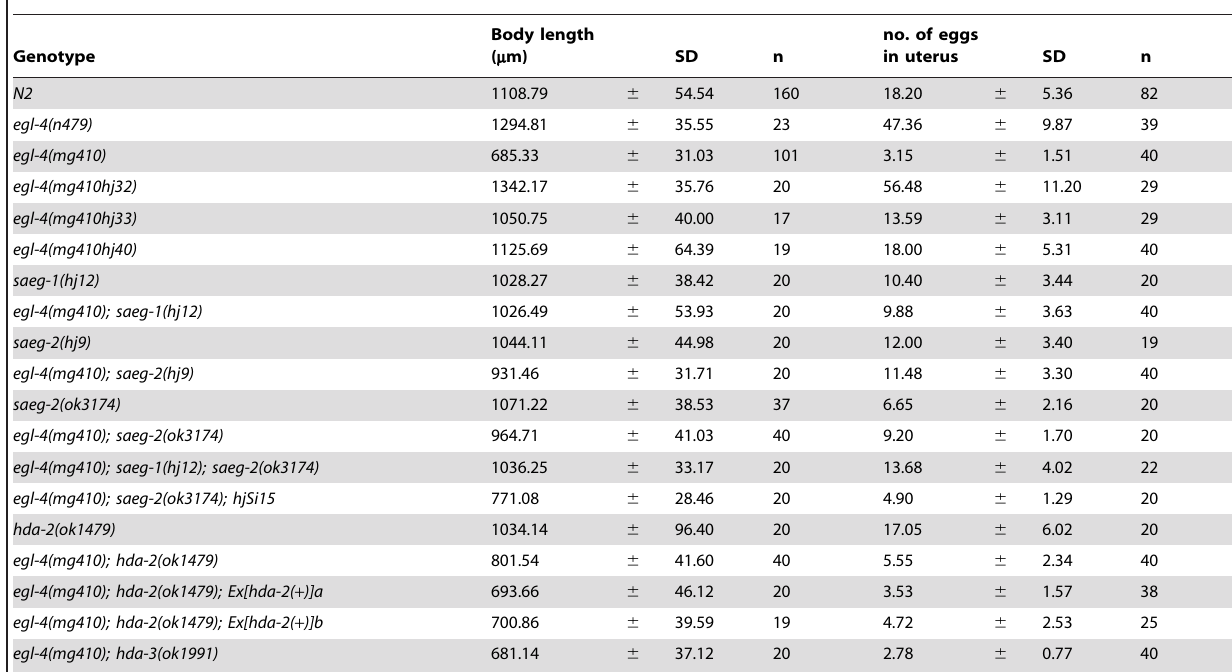
Table 1. Body length and number of eggs in uterus in wild-type and mutant animals.